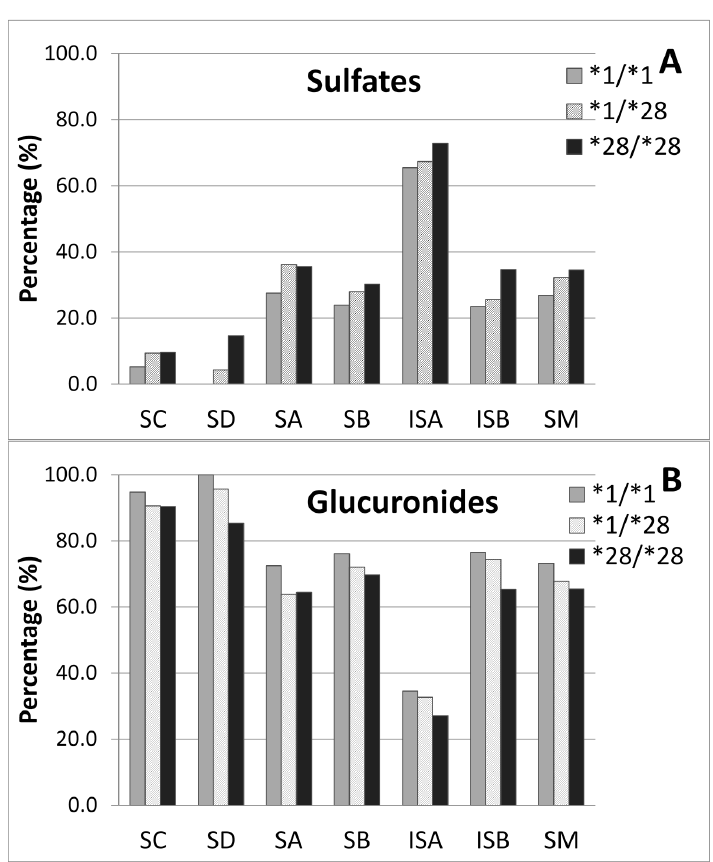
Figure 5. The influence of UGT1A1*28 allele on the percentage of ( A ) sulfate or ( B ) glucuronide conjugates of silymarin flavonolignans in pooled patients’ plasma at 2 h post-dose. Open bar represents UGT1A1 *1/*1 , hatched bar for *1/*28 and closed bar for *28/*28 .